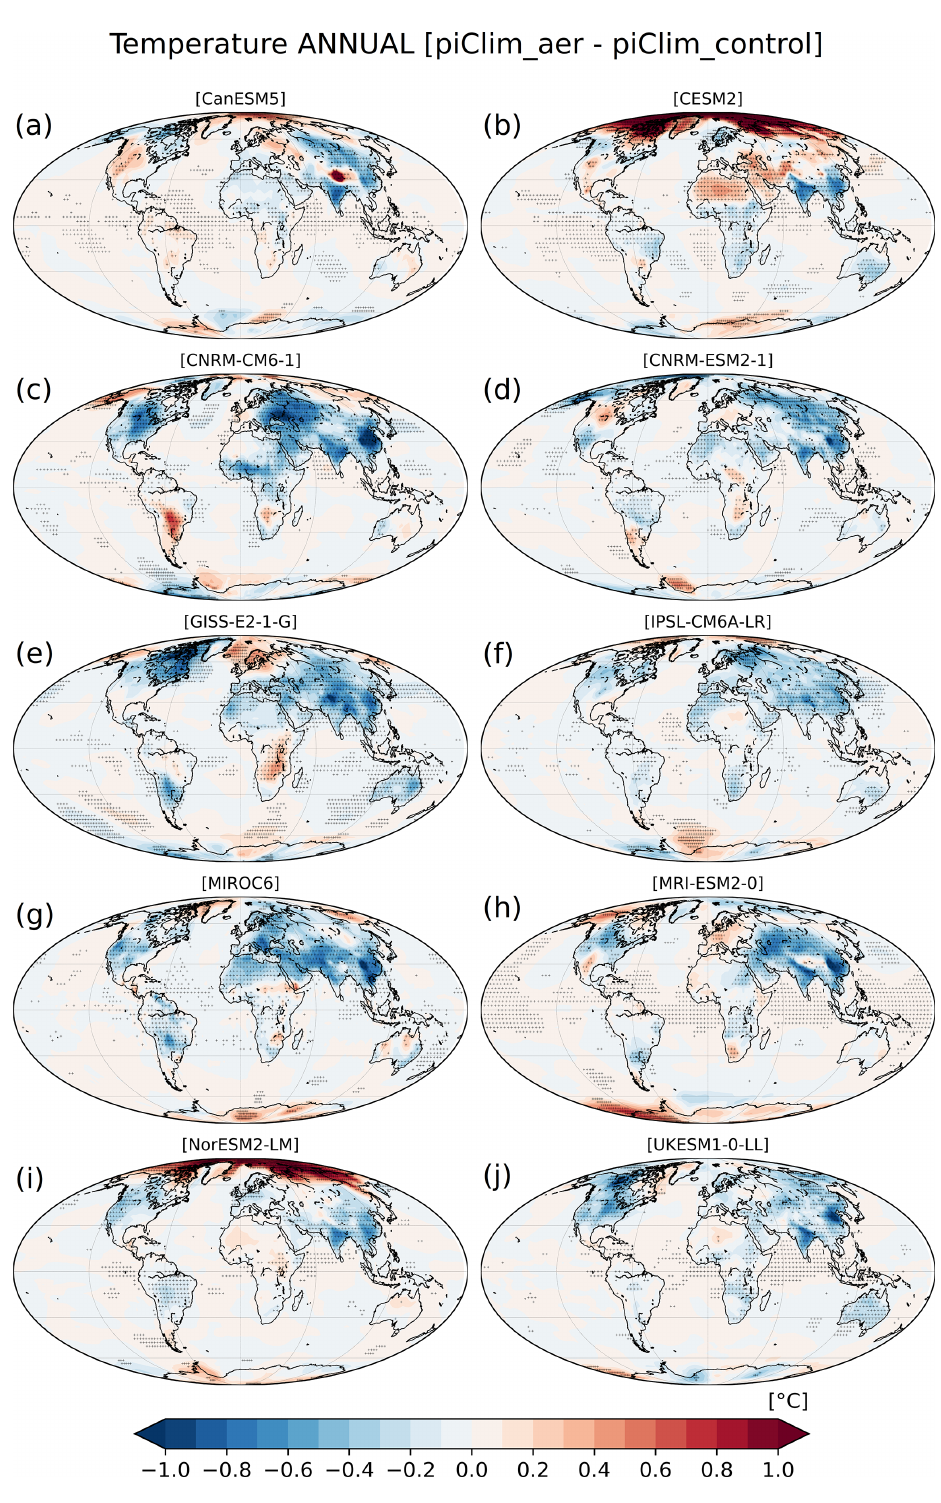
Figure 7. Annual differences between piClim-aer and piClim-control in near-surface temperature ( ◦ C) for each one of the models used for the ensemble. The dot shading indicates areas in which the differences are statistically significant at the 95% confidence level.